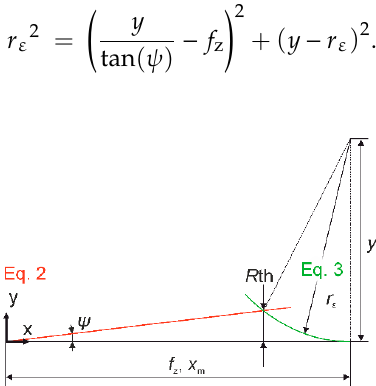
Figure 3. Illustration of the basic geometric relationship of a machining mark in context of tool shape.